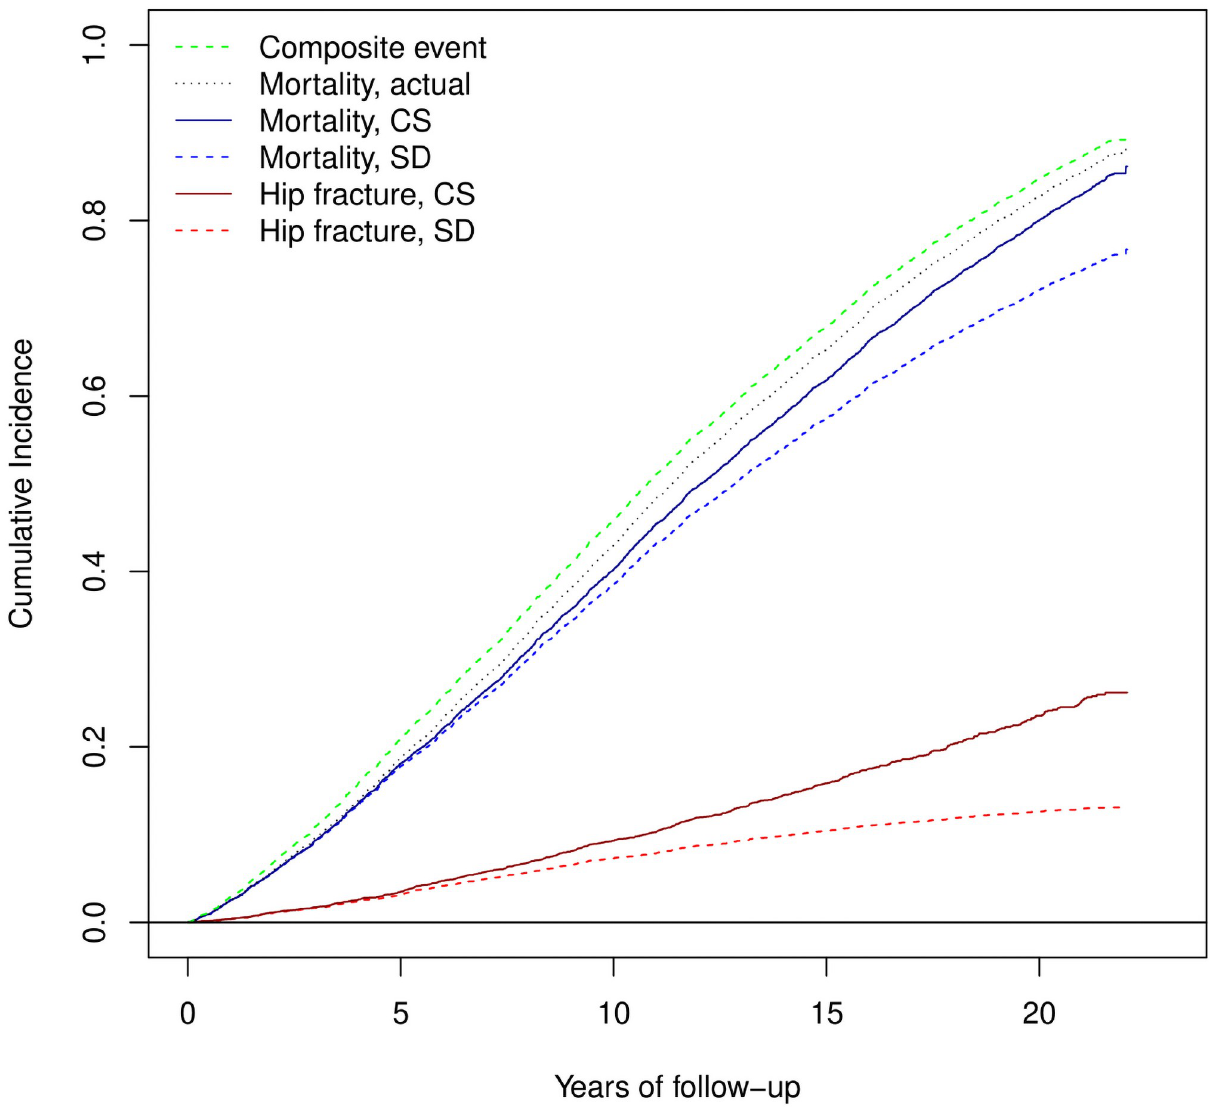
Fig 5. Estimates of cumulative incidence. Cumulative incidence functions estimates for incident hip fracture, mortality and composite